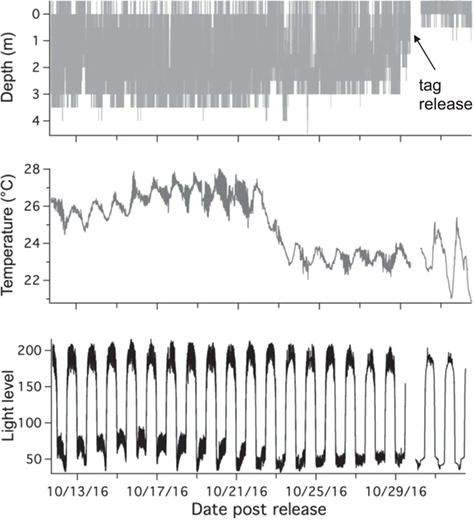
Example of PSAT tag data from a survival (FL08). Constant changes in all variables indicate tag attached and shark is moving and exhibiting survival behaviour